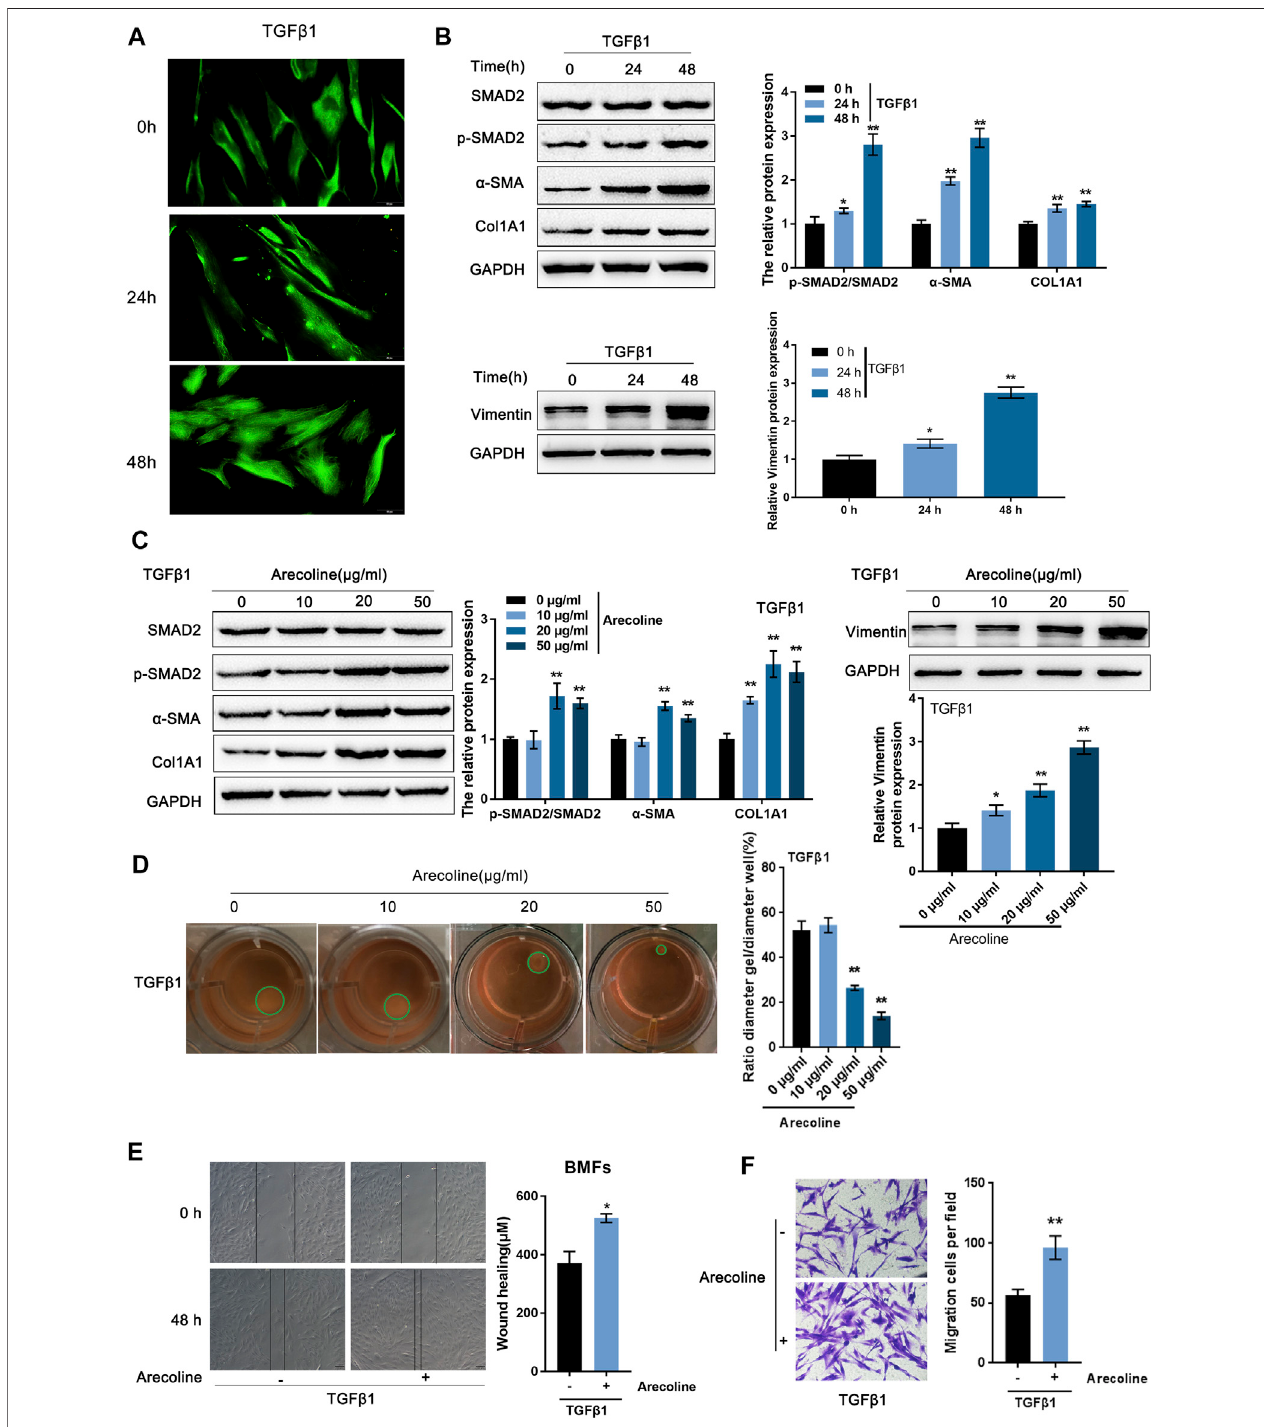
FIGURE1| ArecolineenhancesTGF- β 1-inducedactivationofbuccalmucosal fi broblasts(BMFs). (A,B) BMFswereisolated,treatedwith5 ng/mlTGF- β 1for0,24, and 48 h, and identi fi ed for activation by (A) IF staining with Vimentin antibody and (B) Immunoblotting with Smad2, p-Smad2, α -SMA, Col1A1, and Vimentin. (C,D) Then, BMFs were co-treated with arecoline (0, 10, 20 or 50 µg/ml) and 5 ng/ml TGF- β 1 for 48 h and examined for (C) the protein levels of Smad2, p-Smad2, α -SMA, Col1A1, and Vimentin; (D) the gel contraction capacity. n (cid:1) 3, * p < 0.05, ** p < 0.01 compared with control group. ANOVA followed bya Tukey post-hoc test. (E,F) BMFs were treated with 5 ng/ml TGF- β 1 in the presence or absence of 20 µg/ml arecoline for 48 h and examined for the migration capacity by Wound healing and Transwell assays. n (cid:1) 3, * p < 0.05, ** p < 0.01 compared to TGF- β 1 treated group. student t -test.